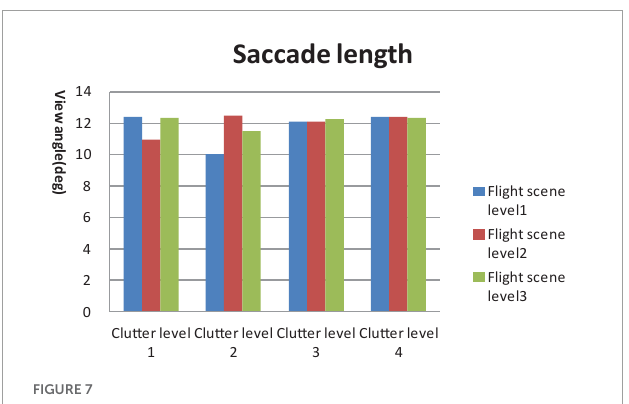
FIGURE7 General linear model (GLM) Univariate test of saccade length.